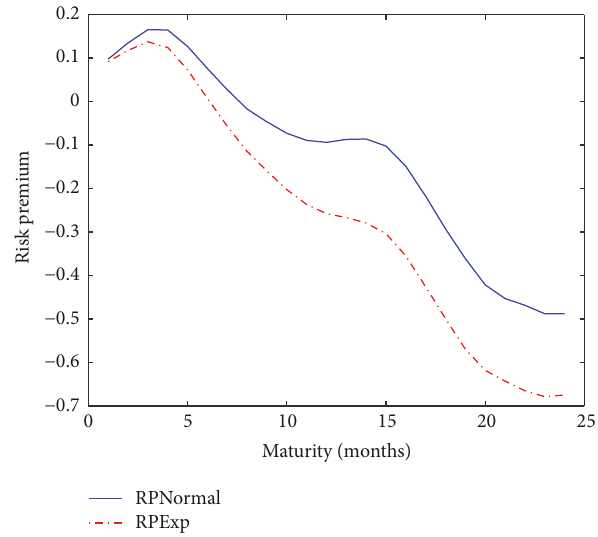
Figure 3: The risk premium as a function of time to maturity for the JDMN and JDMExp